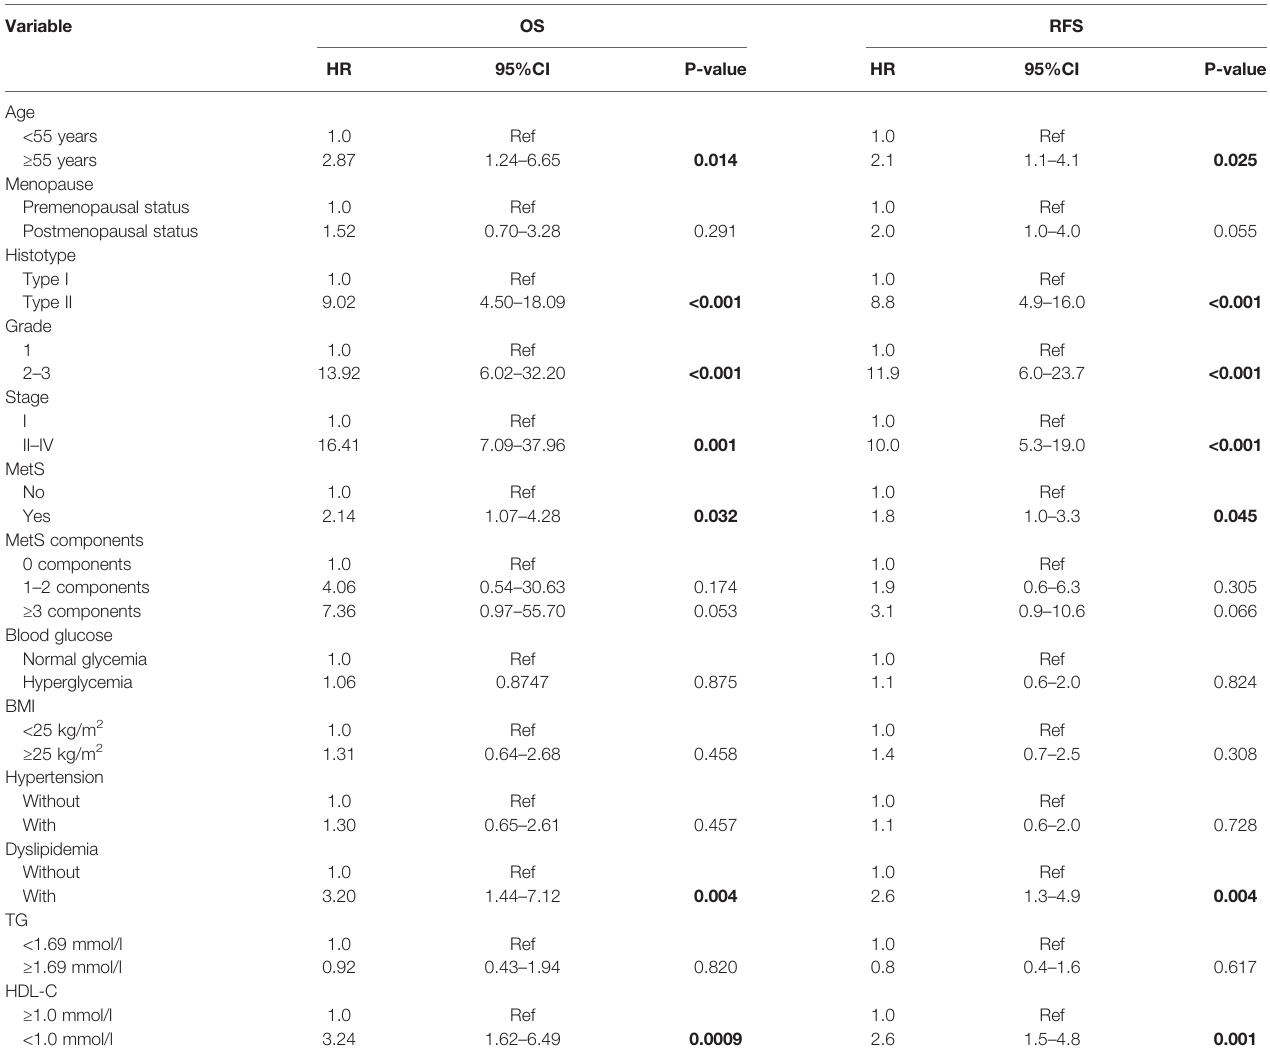
TABLE 3 | Univariate analysis of OS and RFS for EC